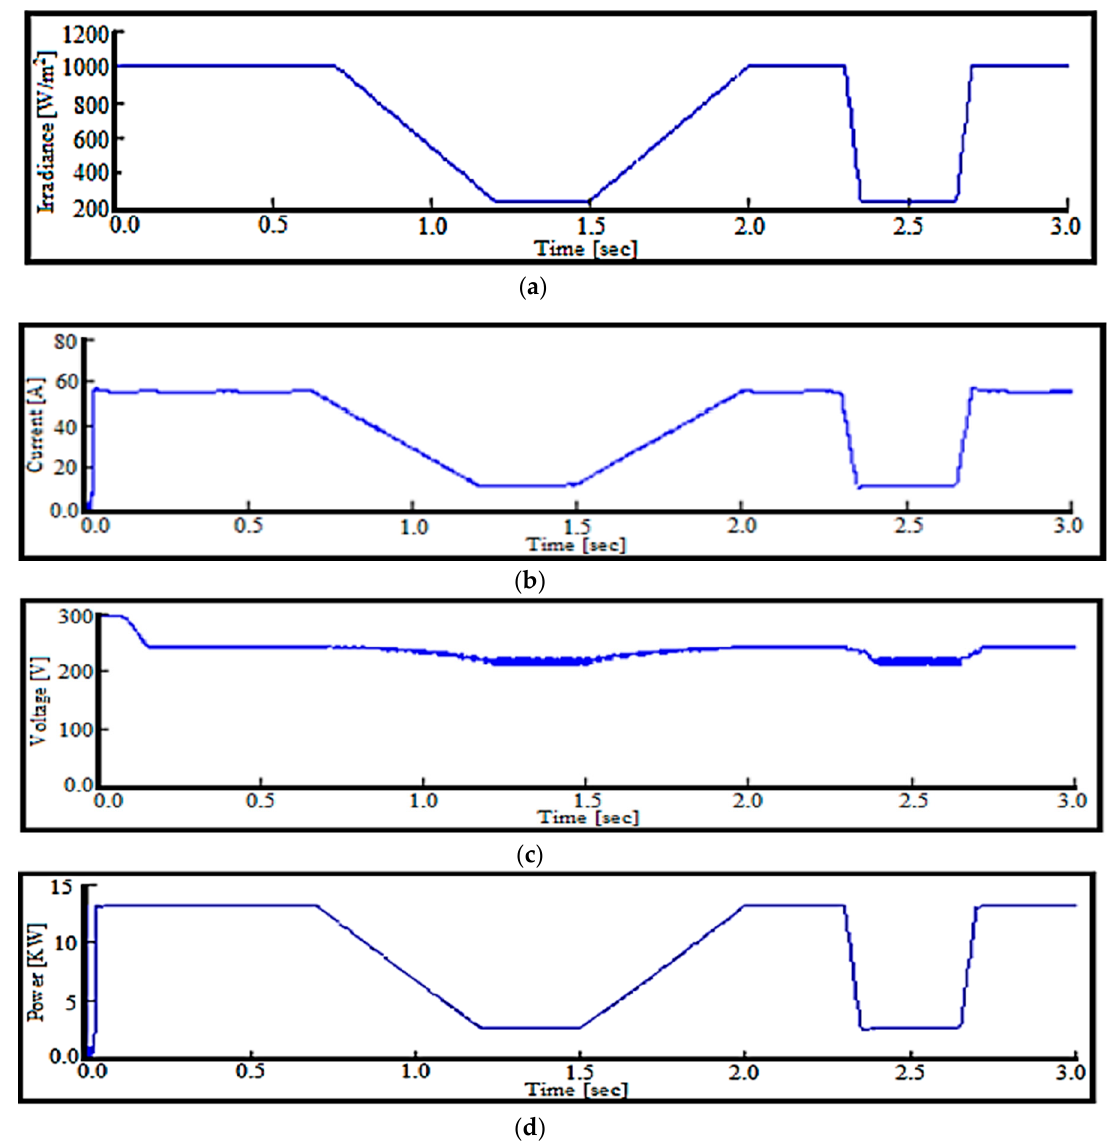
Figure 24. ( a ) Irradiance vs. Time of P&O at PV side; ( b ) Current vs. Time of P&O at PV side; ( c ) Voltage vs. Time of P&O at PV side; ( d ) Power vs. Time of P&O at PV side.